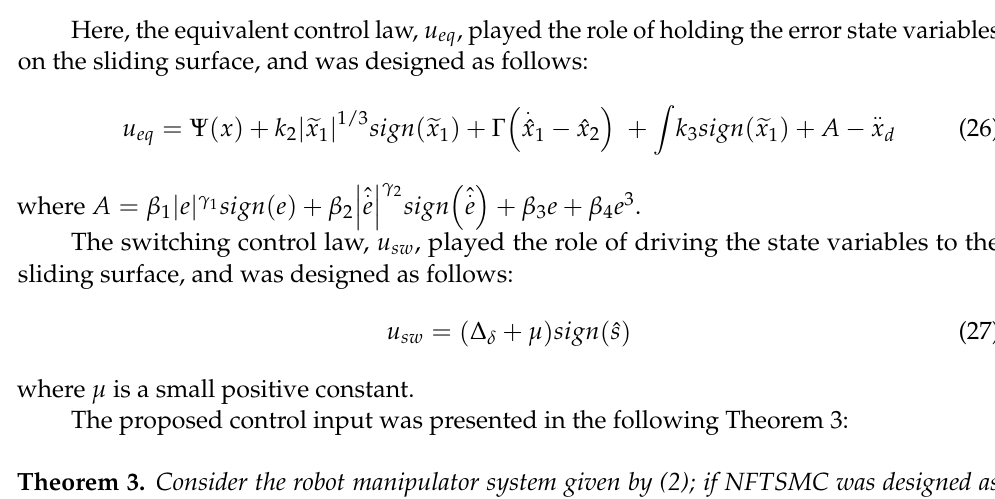
Figure 1. Overall structure of the proposed fault-tolerant control